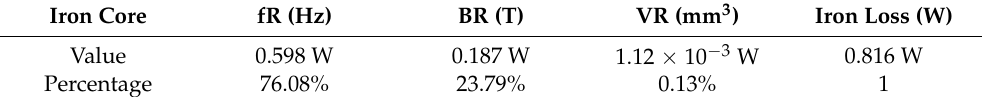
Table 6. Percentage of different iron loss types.